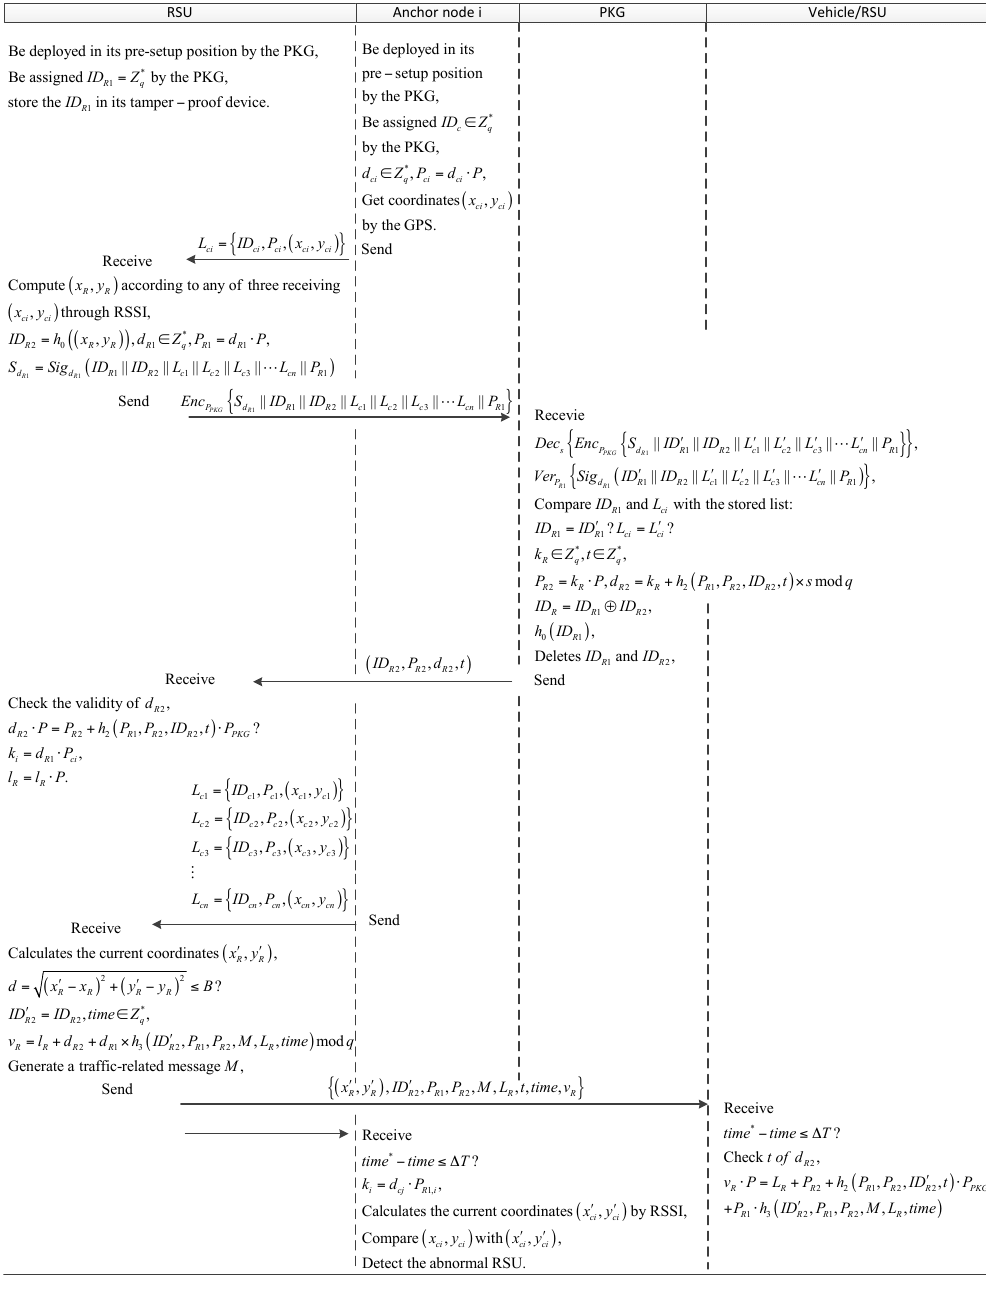
Figure 5. The RSU to vehicle (RSU) authentication process.